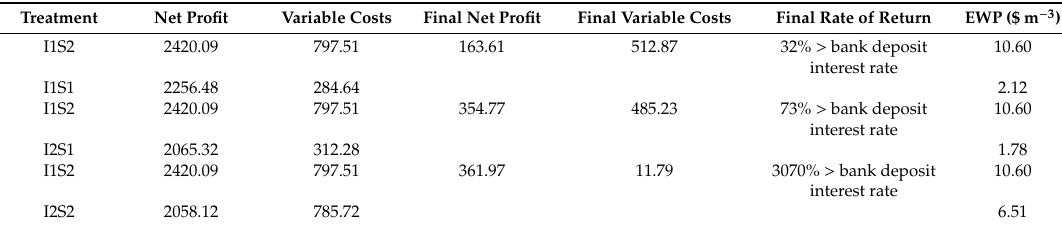
Table 10. Analysis of the final rate of return on